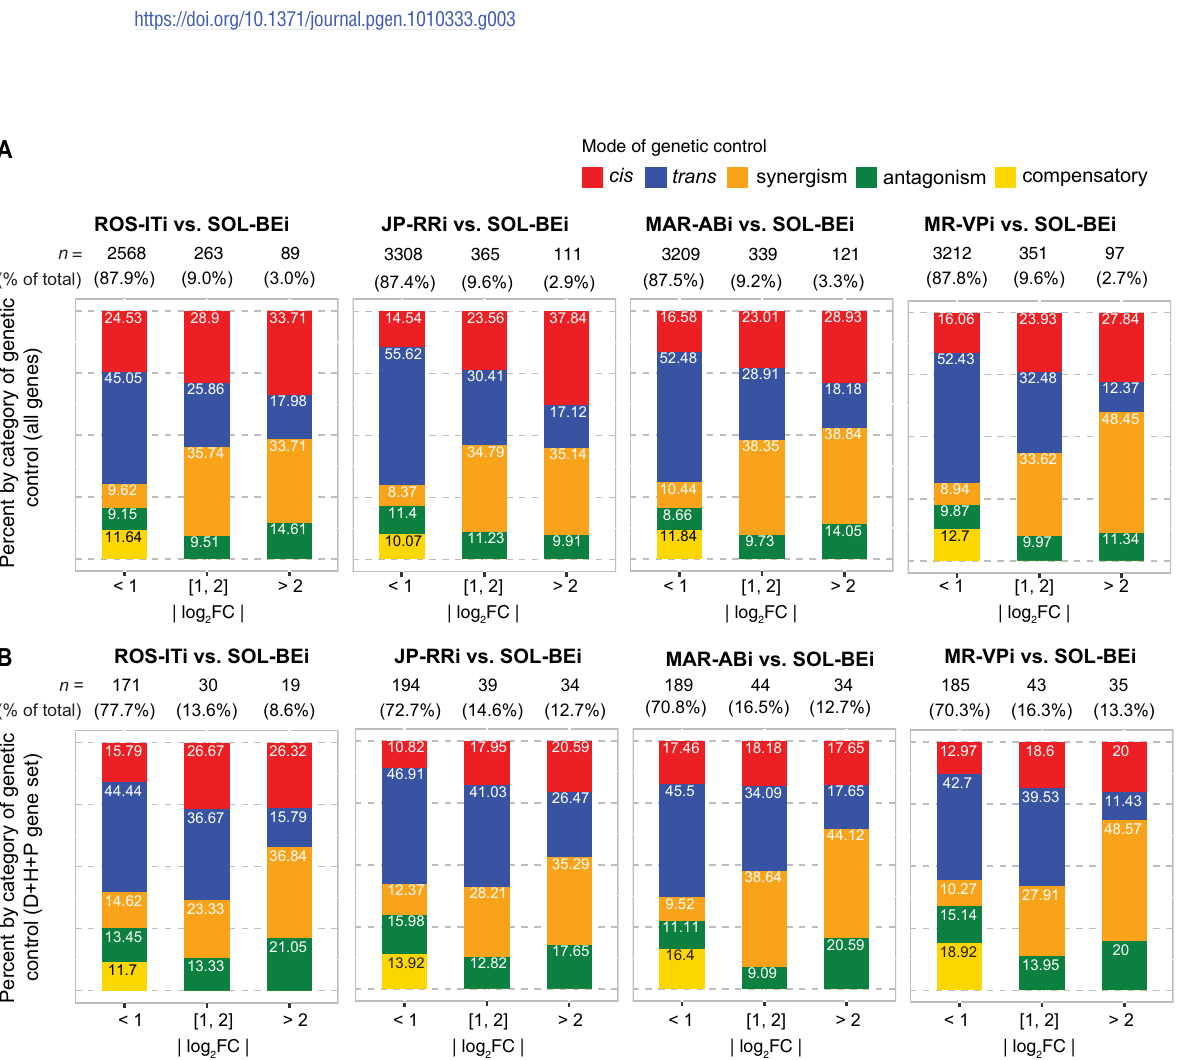
Fig 3. Regulatory modes associated with gene expression variation in comparisons of parental strains and allele-specific expression in F1s. (A-D) For the comparisons of ROS-ITi (A), JP-RRi (B), MAR-ABi (C), and MR-VPi (D) to SOL-BEi, scatter plots show log 2 fold changes (log 2 FC) for genes with assigned genetic modes of control between the respective parents (y-axis) versus respective log 2 FC for allele-specific expression in F1s (x-axis) (genes assigned to conserved or ambiguous modes are not shown; log 2 FC values falling outside the plotting scale of -10 to 10 were rescaled to these plotting limits). Each point represents a single gene, with color coding by mode of genetic control as indicated (see insets for color codes and respective gene numbers; n , total sample size, upper left). (E-H) Respective plots for panels A-D for detoxification/host/peptidase (D+H+P) genes with moderate to large absolute value of log 2 FC ( > 1) along one or more axes. Different symbols and outline colors denote membership in D+H+P gene families or classifications (see legends to the right of each panel). The interiors of plotting symbols are color coded by the regulatory categories as indicated in the insets ( n , total sample size, upper left). For each D+H+P gene family or classification, the three numbers in parentheses in the legends represent ( i ) the number of genes shown in each panel with cis , trans , synergism, antagonism, and compensatory mode assignments for which |log 2 FC| > 1, ( ii ) genes with the same selection criteria except with no log 2 FC cutoff applied, out of ( iii ) the total number of genes for which any mode of genetic control could be assigned (including conserved and ambiguous; see also S2 Fig). The data upon which this figure is based are provided in S4 Table.